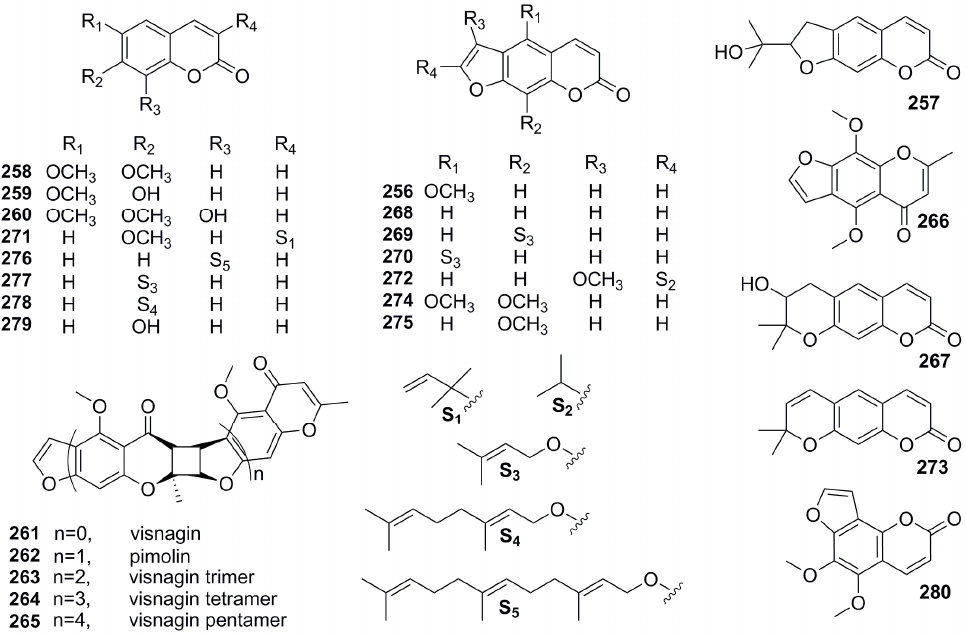
Figure 6. Chemical structures of coumarins.